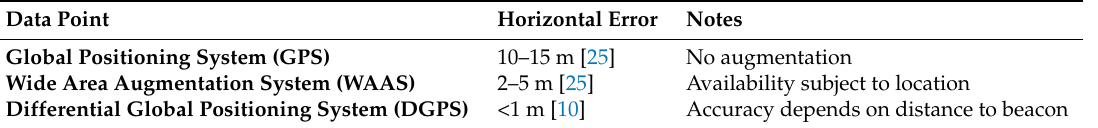
Table 1. Summary of horizontal error for different augmentation techniques.